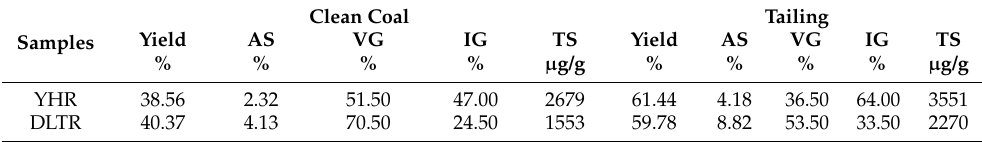
Table 4. Triboelectrostatic separation results of Zhundong and Shenfu coal.